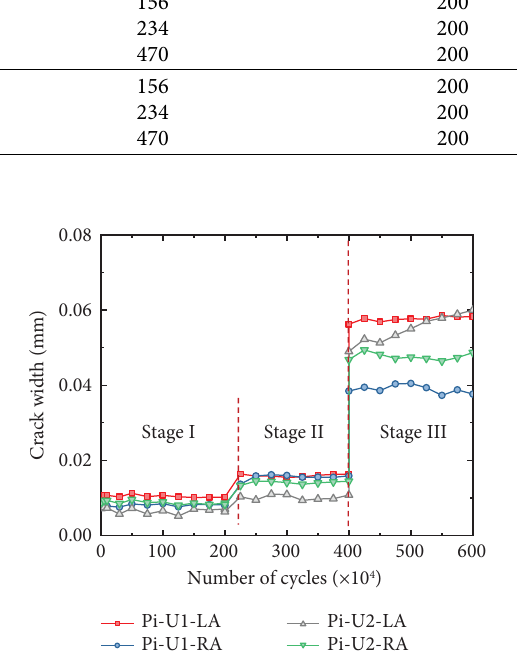
Figure 10: Variation laws of crack width during fatigue